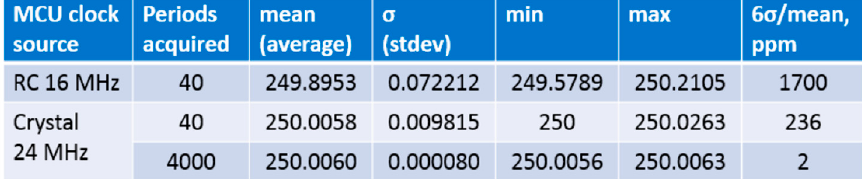
Figure 6. Statistical parameters of the acquired time series.